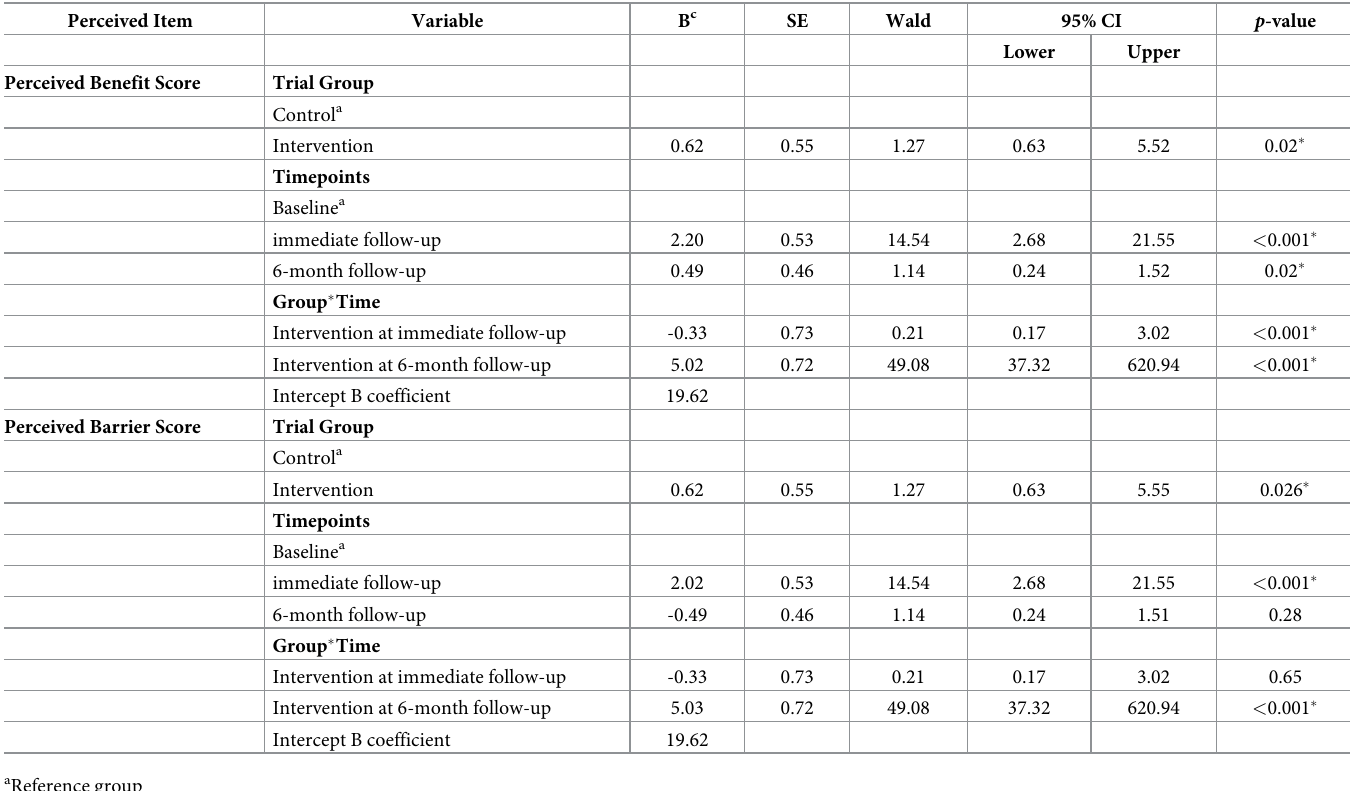
Table 8. Effectiveness of HEBI on perceived benefit and perceived barrier